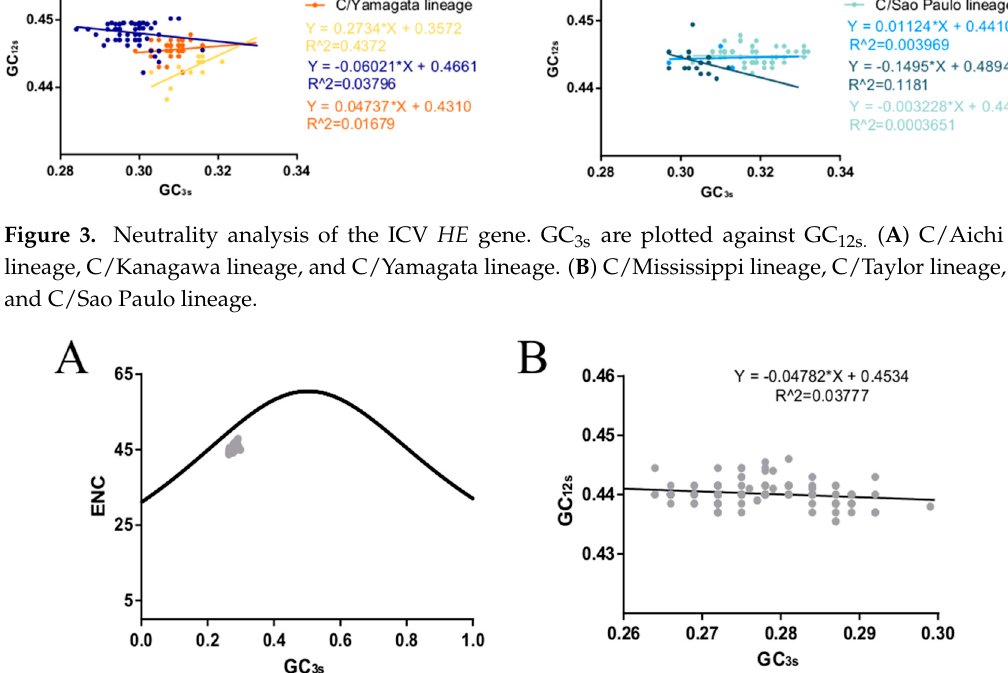
Figure 4. Effective number of codons (ENC) ( A ) and the neutrality analysis ( B ) of the ICV M gene.